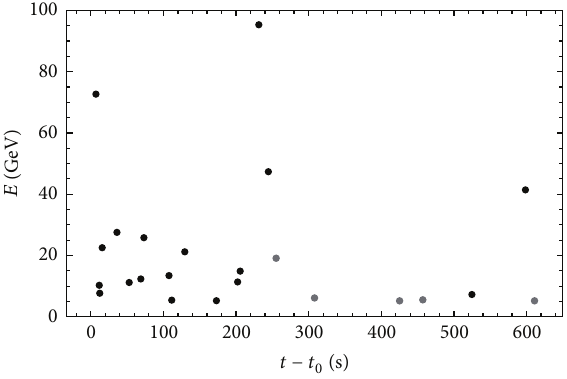
Figure 2: Times and energies of detection of GRB130427A photons with energy in excess of 5GeV, selected within 10 degrees of the GRB130427A optical position. Darker points are for photons